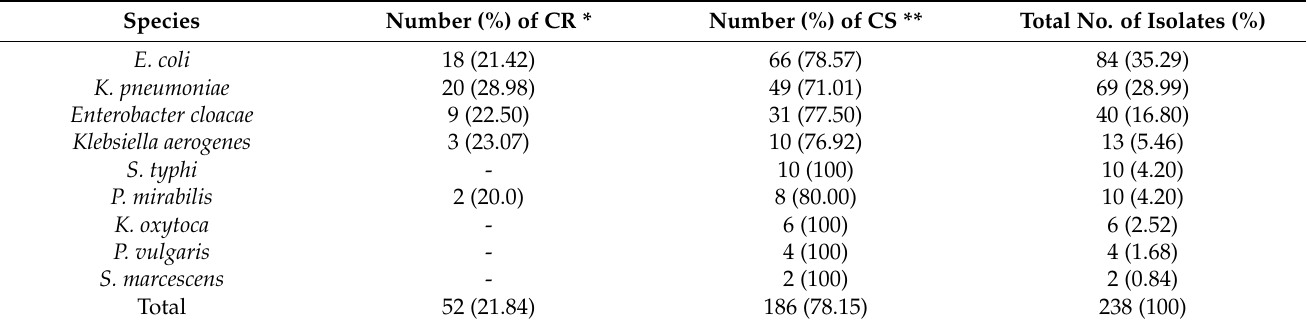
Table 1. Proportion of different species of Enterobacteriaceae ( n = 238).